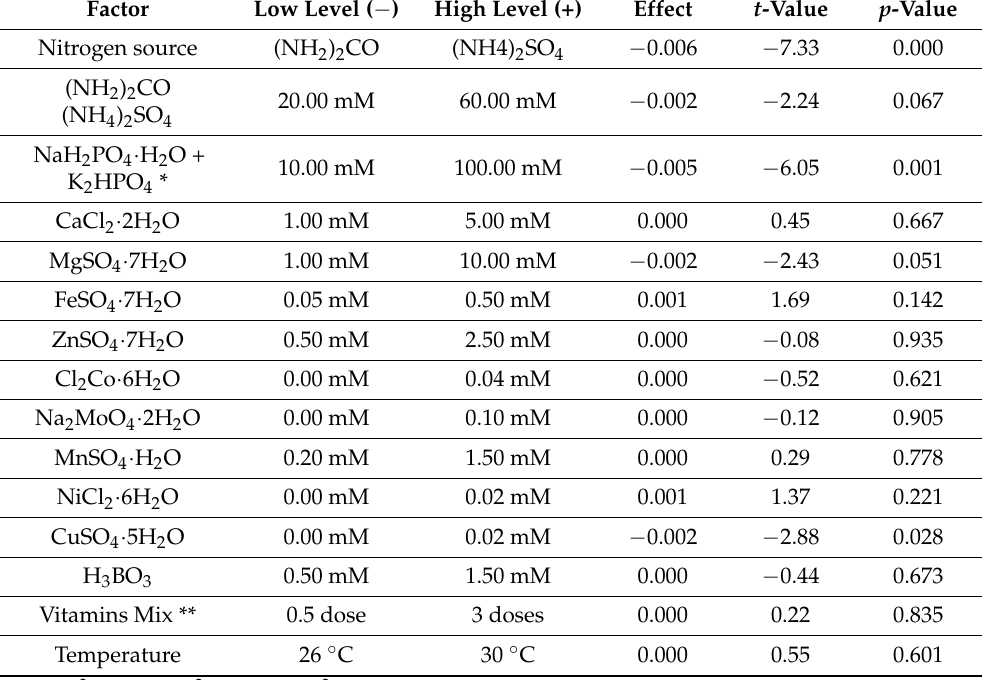
Table 1. Statistical analysis of Plackett–Burman experiment for specific growth rates of heterotrophic